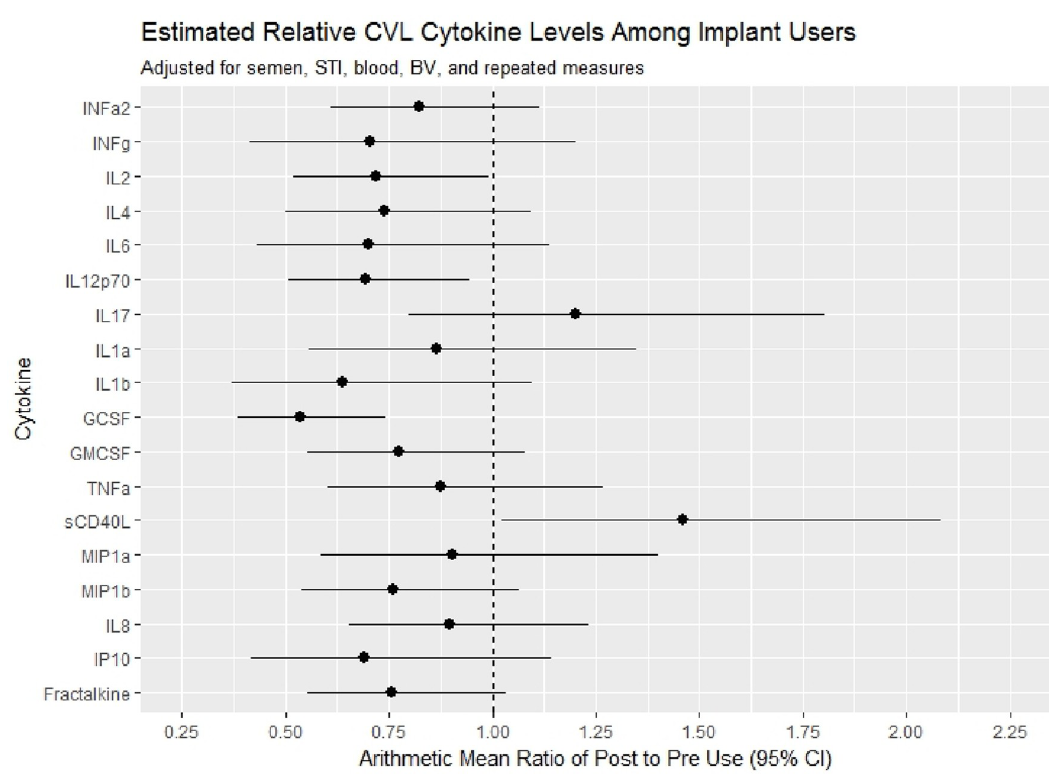
Fig 3. Forest plot of arithmetic mean ratio of cytokine levels post-implant compared to pre-implant use with 95% confidence intervals, adjusting for time-varying semen presence by PSA, sexually transmitted infections, bacterial vaginosis, presence of blood in the sample and repeated measures.